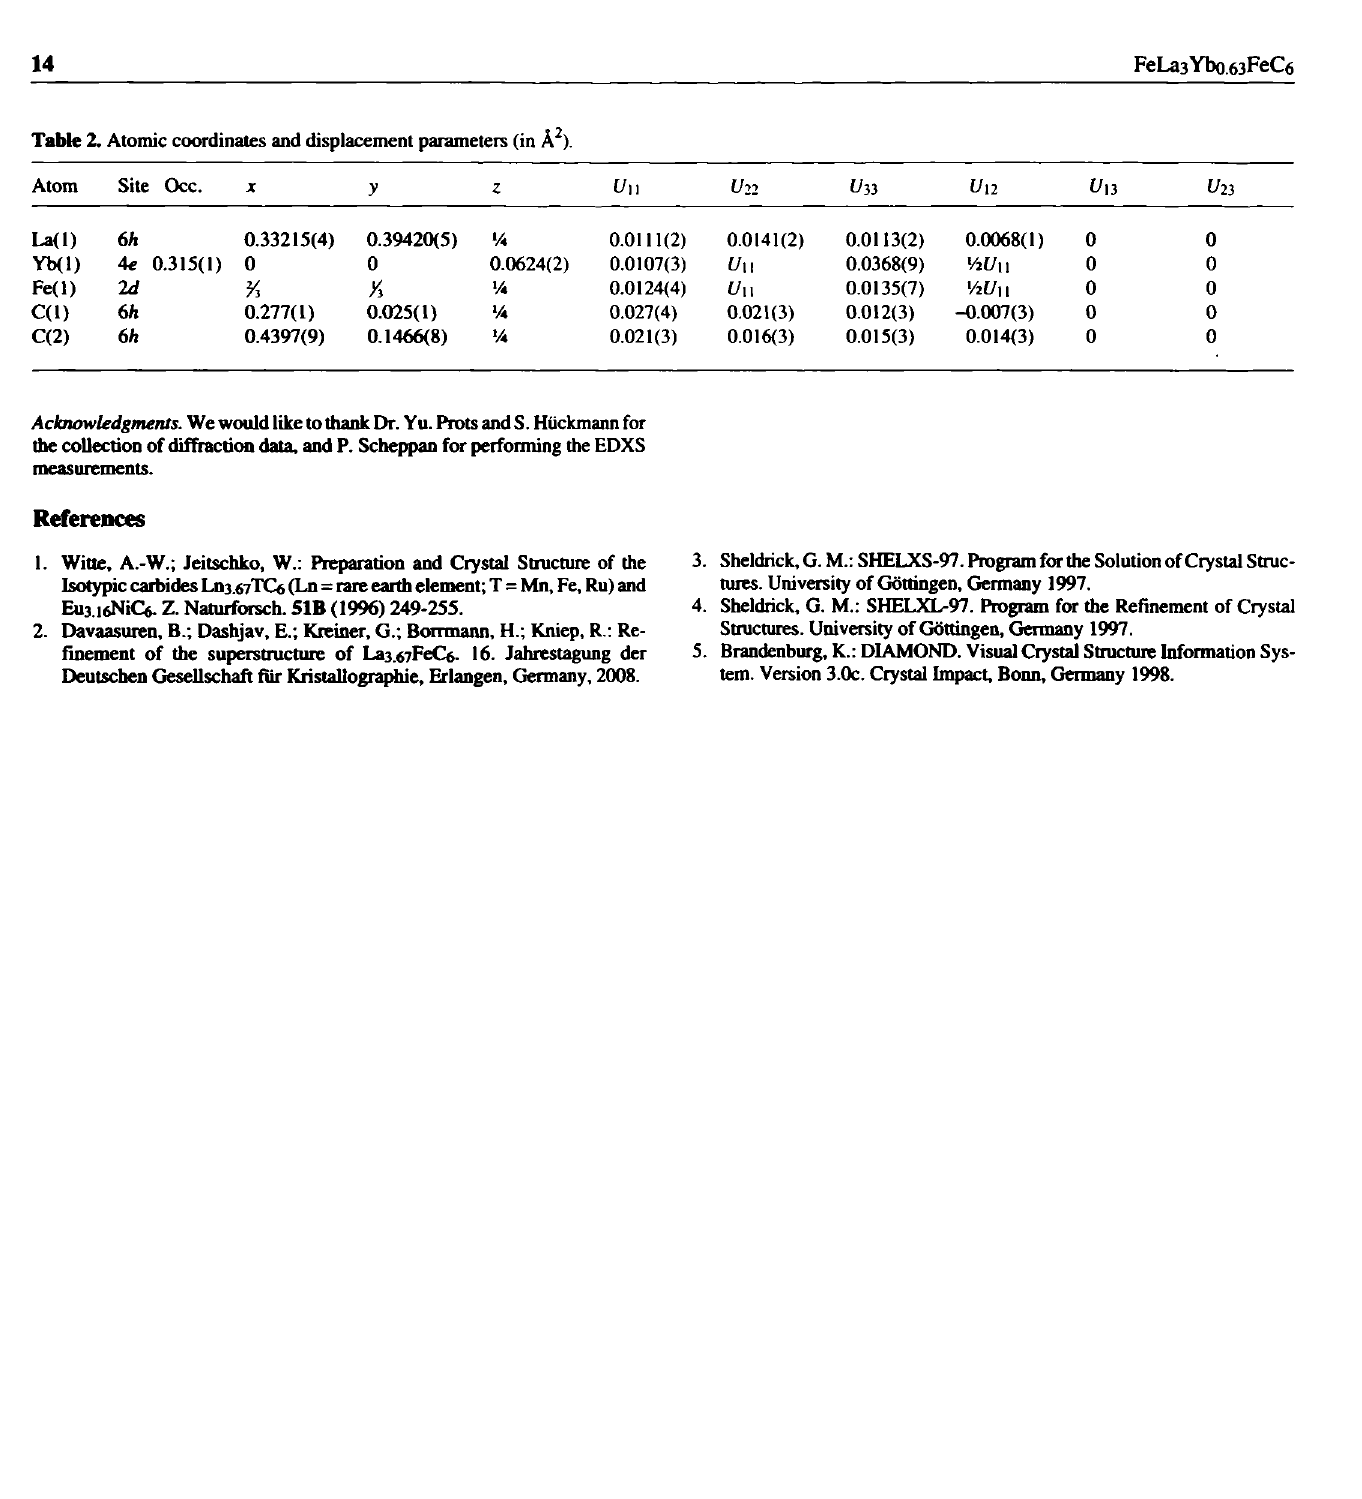
Table 2. Atomic coordinates and displacement parameters (in Â 2